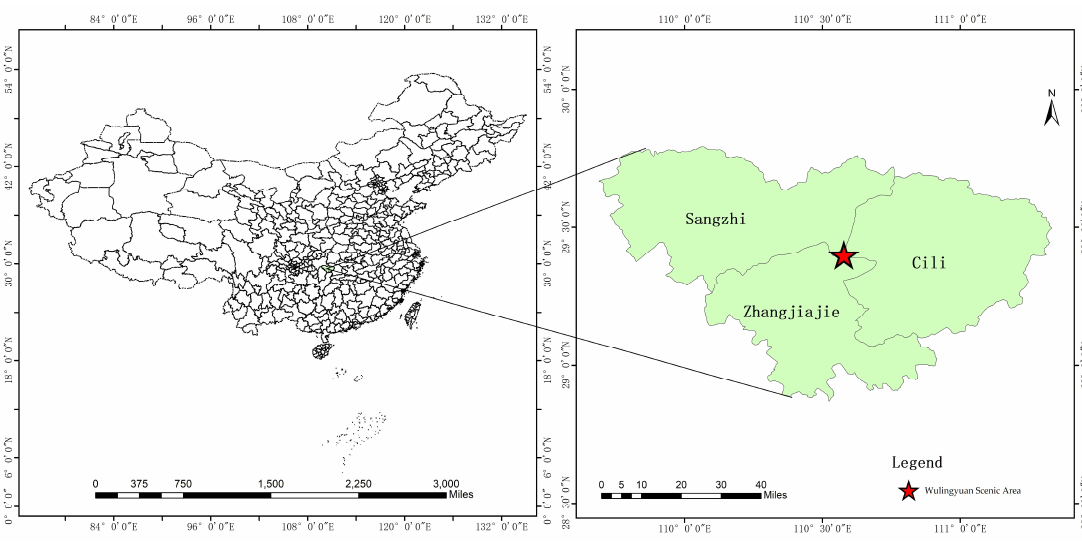
Figure 1. The location map of the study area.